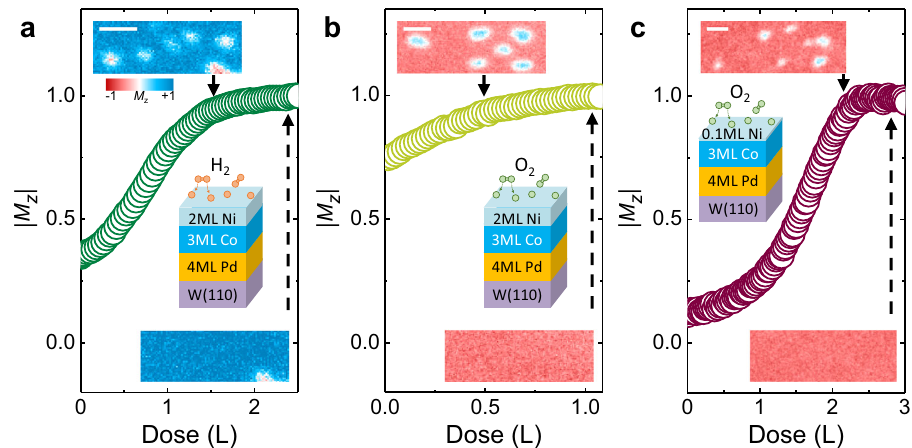
Fig. 5 The role of chemisorbed hydrogen and oxygen on magnetic anisotropy and skyrmions on surfaces of other magnetic layers. a Hydrogen-induced anisotropy change ( M z , integrated from SPLEEM images in insets) and skyrmion deleting (insets) on surface of 2 ML Ni/3 ML Co/4 ML Pd/W(110). The hydrogen pressure is 1.5 × 10 − 8 torr. The scale bar in the inset is 500 nm. b , c Oxygen induced anisotropy change ( M z ) and skyrmion deleting (insets) on surface of 2 ML Ni/3 ML Co/4 ML Pd/W(110) (panel b ) and 0.1 ML Ni/3 ML Co/4 ML Pd/W(110) (panel c ). Scale bars in the insets are 500 nm.